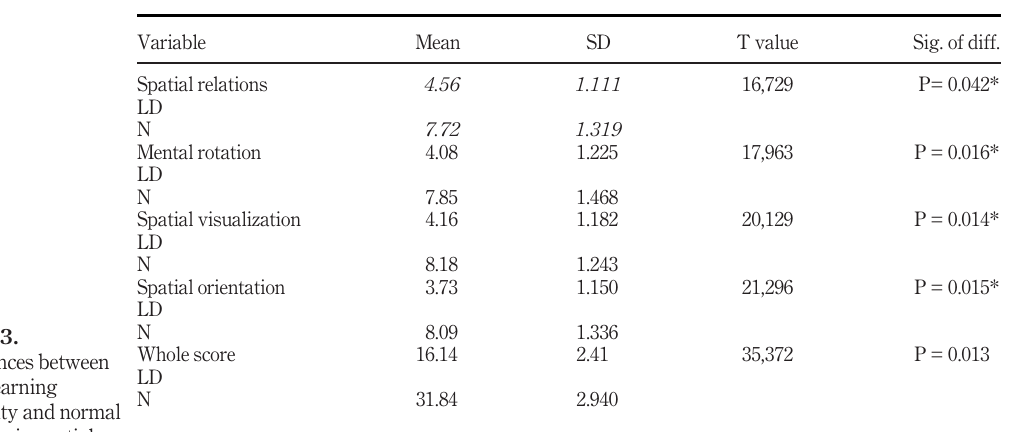
Table 2. Descriptive statics of age